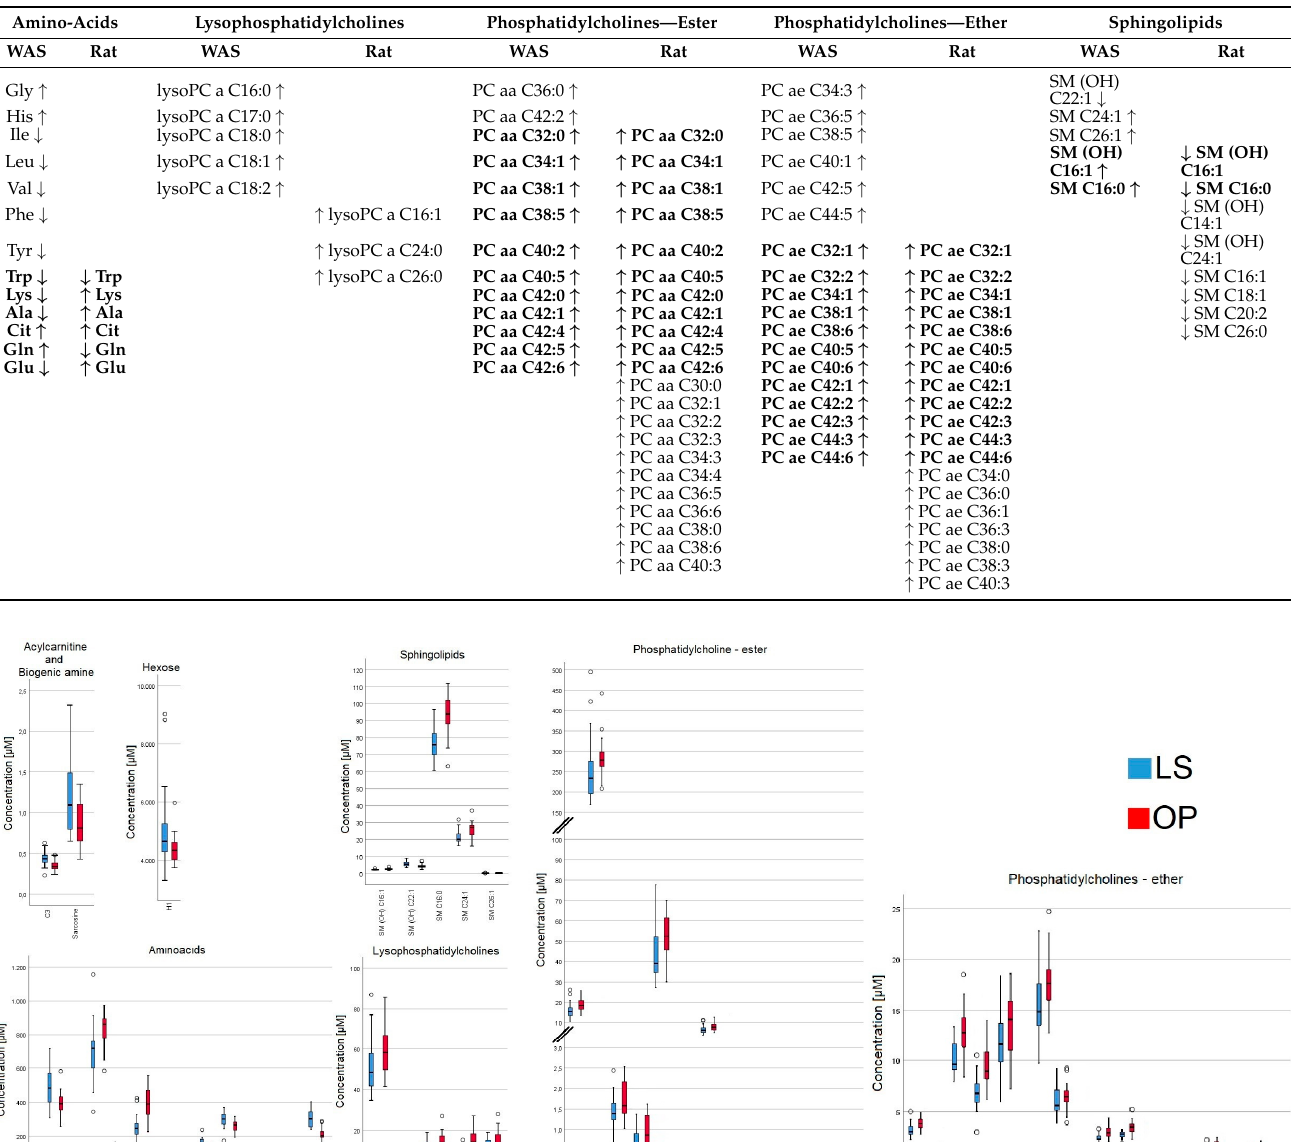
Table 4. Eighty-one significantly different metabolites subsequently in LS vs. OP of the WAS cohort at one-year follow-up and in animals treated with RYGB vs. diet-restricted animals of the rat cohort four weeks after start of the interventions. Thirty-one overlapping metabolites found to be significant in both comparisons are printed in bold. Arrows indicate if the metabolite is increased or decreased in the respective surgical group in comparison the conservative group. C, acylcarnitine; lysoPC, lysophosphatidylcholine; PC aa, phosphatidylcholine with ester bonding; PC ae phosphatidylcholine with ether bonding; SM, sphingolipid.